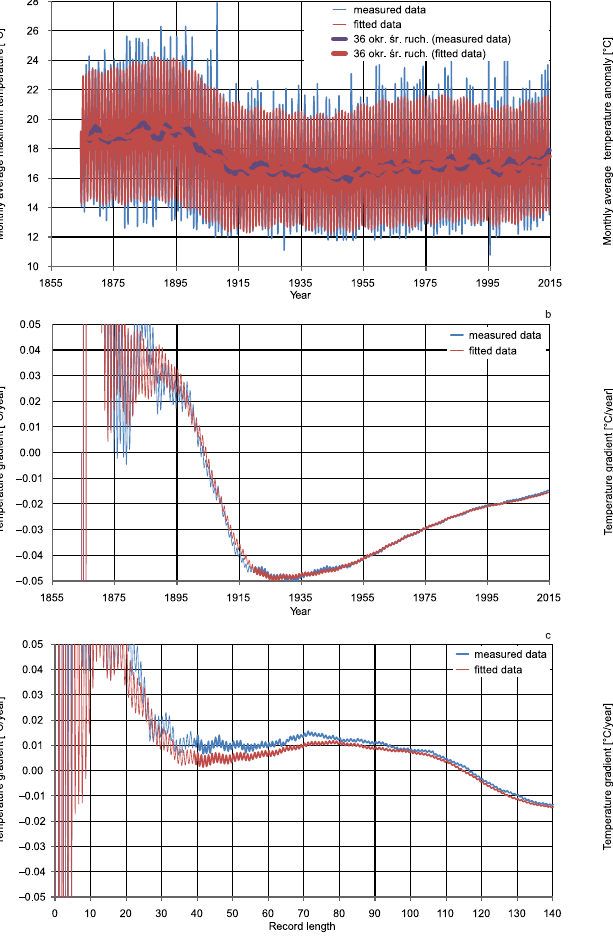
Fig. 5. Analysis of the monthly mean GISS 1200 T2m/SST global temperature anomaly index: a) reconstructed monthly mean and results obtained by a fitting with a line and sines with 36 months average trends; b) time rate of change of the monthly mean measured and fitted as a function of time; c) time rate of change of the monthly mean measured and fitted as a function of the record length. Data from KNMI (2014) accessed October 12,